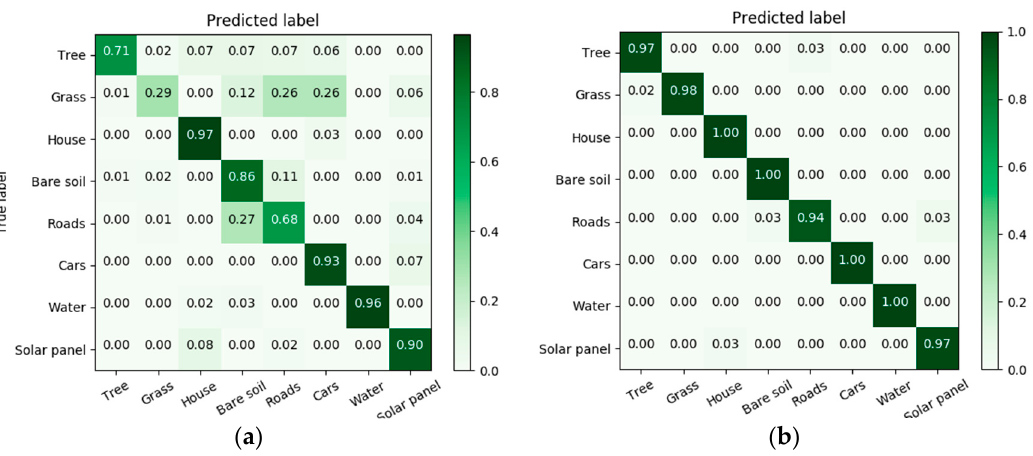
Figure 9. Confusion matrices for Potsdam → Vaihingen: ( a ) NN; ( b ) Siamese-GANs.